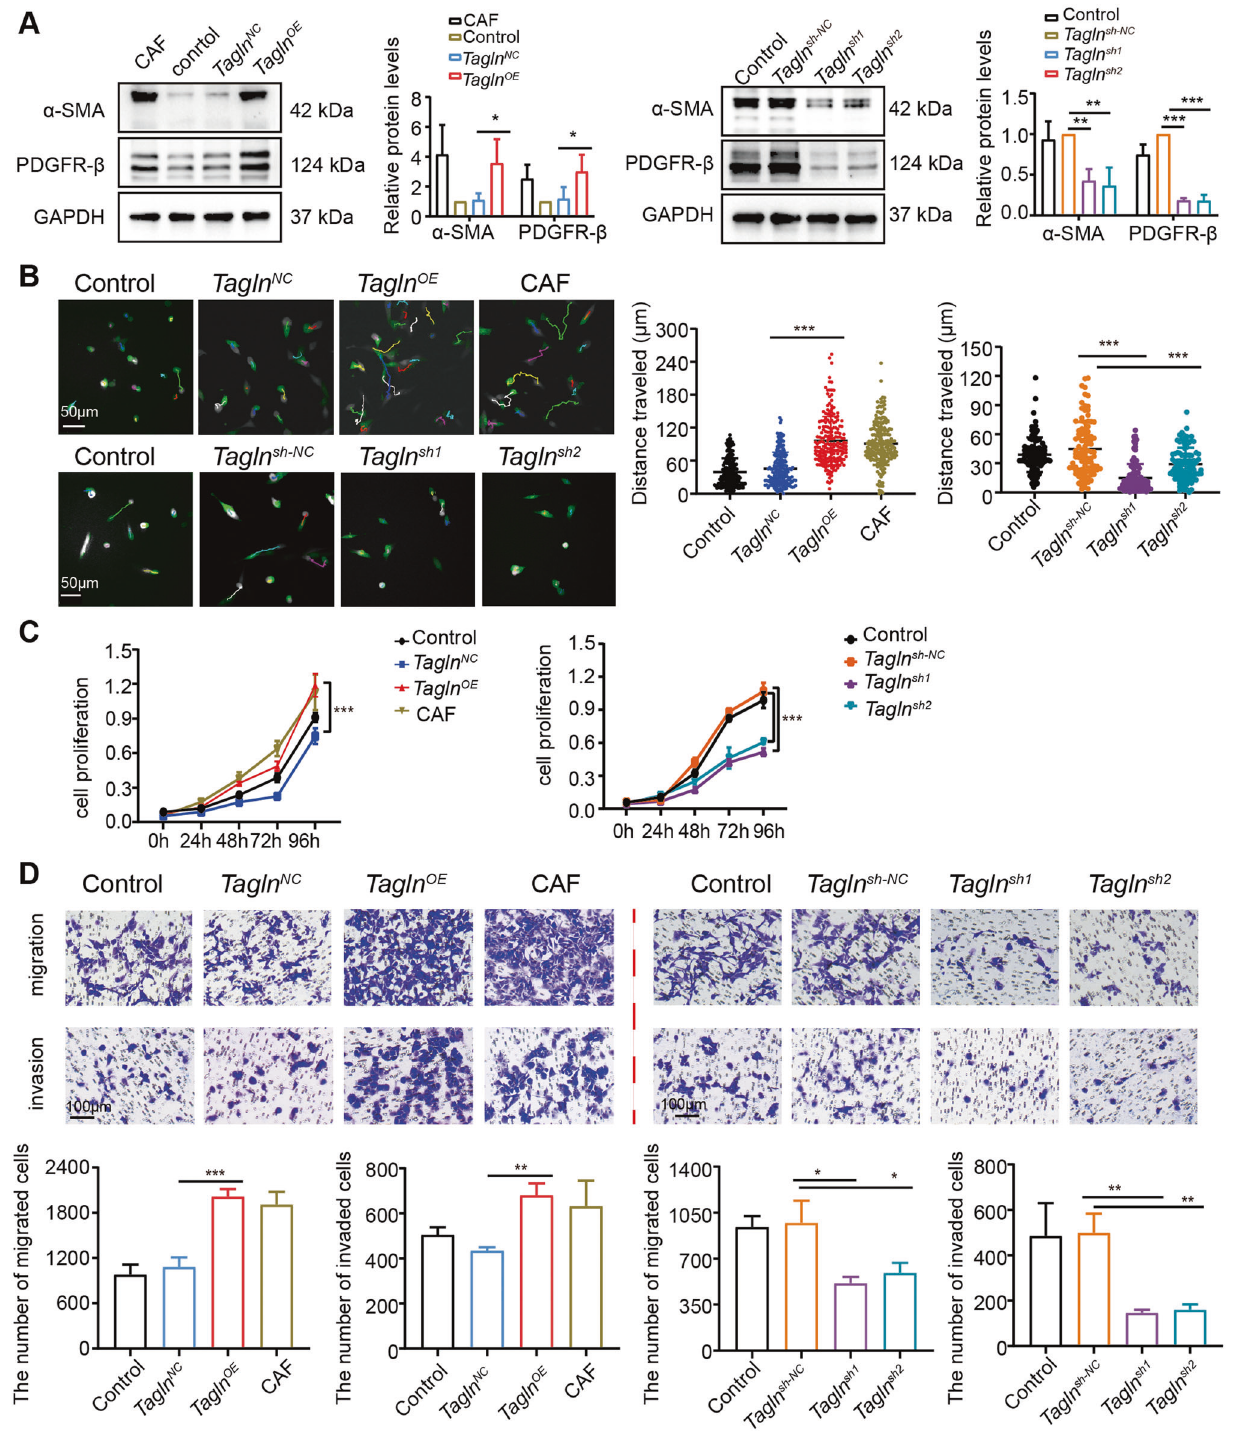
Fig. 3 Transgelin promotes fi broblasts activation. A The effect of transgelin (TAGLN) on the protein levels of cancer-associated fi broblast (CAF) markers, evaluated by western blot ( n = 3). B Representative images of time-lapse microscopy imaging of immortalized mouse embryonic fi broblast (iMEF) overexpressing Tagln or with Tagln knockdown. Each color line represents the tracking of a different cell. Total distance traveled for different fi broblasts. ( Tagln OE iMEF n = 240, Tagln sh iMEF n = 120). Scale bar: 50µm. C Changes in iMEF cell proliferation with Tagln overexpression or knockdown. D Effects of Tagln overexpression or knockdown on cell migration and invasion. *** p <0.001, ** p <0.01, * p cells [35 – 37]. To investigate the function of Tagln -overexpressing Tagln-overexpressing fi broblasts promote cell migration, fi broblasts in tumor cells, we performed 3D-gel invasion assays. invasion and cancer cell stemness in lung cancer cells Results showed increased LLCs cell invasion (Fig. 4A) after indirect CAFs are known to contribute to tumor development and co-culture with Tagln OE iMEFs. Next, we cultured LLCs with CM progression by regulating the malignant phenotype of tumor